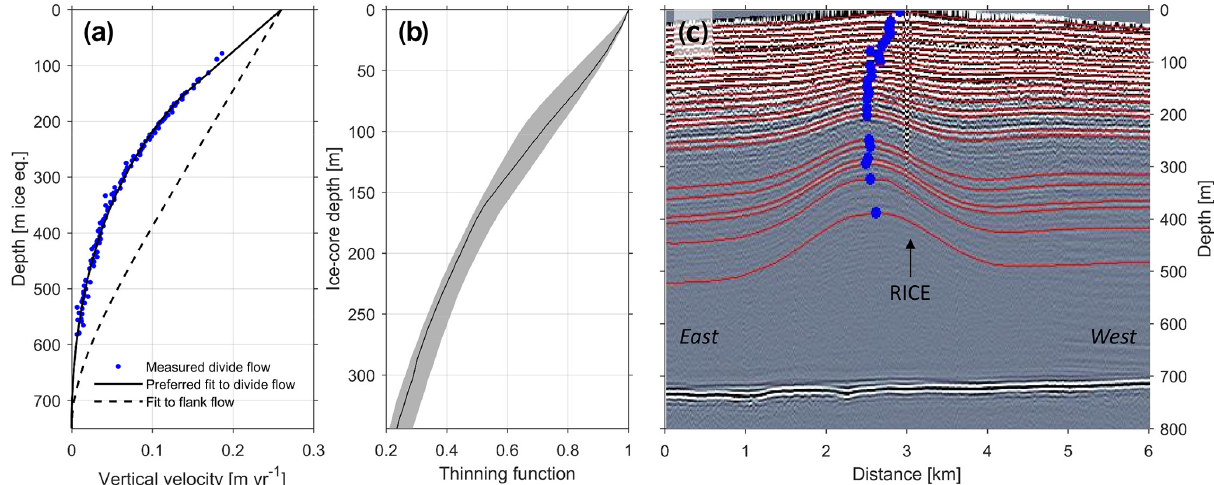
Figure 7. (a) Vertical velocity profiles for divide-like flow and flank flow (Kingslake et al., 2014). For divide flow the preferred Lliboutry fit is plotted along with the measured vertical velocities (blue dots). (b) Thinning function with associated 95% confidence interval. (c) Radar echogram (Kingslake et al., 2014) with traced layers (red) and location of maximum amplitudes of the stack of Raymond arches (blue circles). The location of the modern topographic ice divide (and the RICE drill site) is marked by the returns from a pole. The core site is located west of the maximum bump amplitudes at